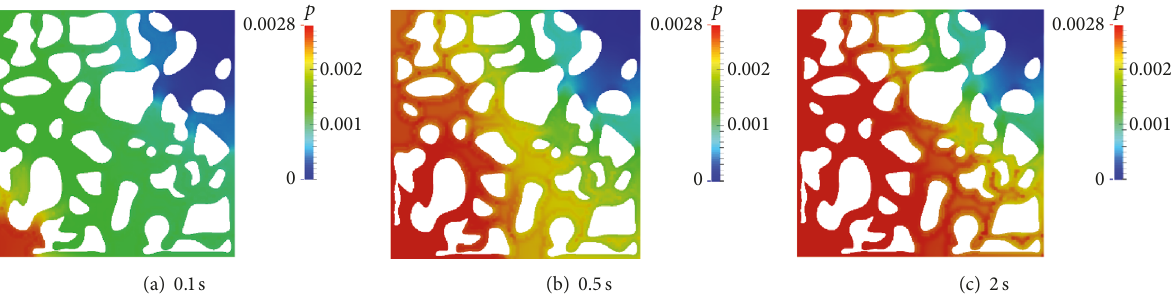
Figure 7: The pressure distribution diagram of the polymer solution injected at different times ( 𝜆 = 0.15 s).